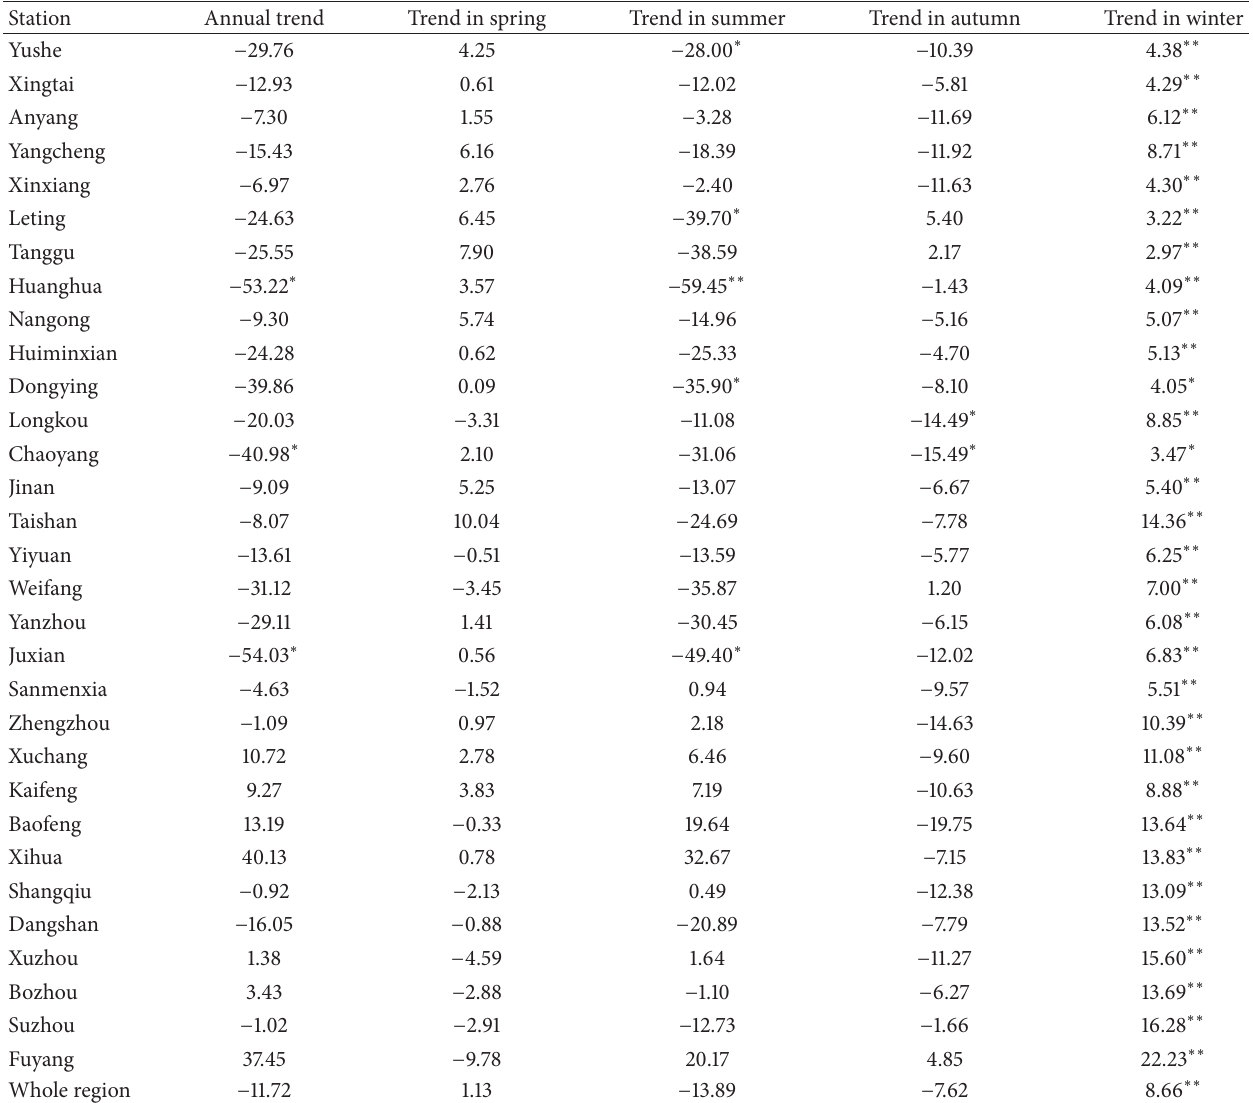
Table 2: Annual precipitation trend, precipitation trend in spring, precipitation trend in summer, precipitation trend in autumn, precipitation trend in winter, and their